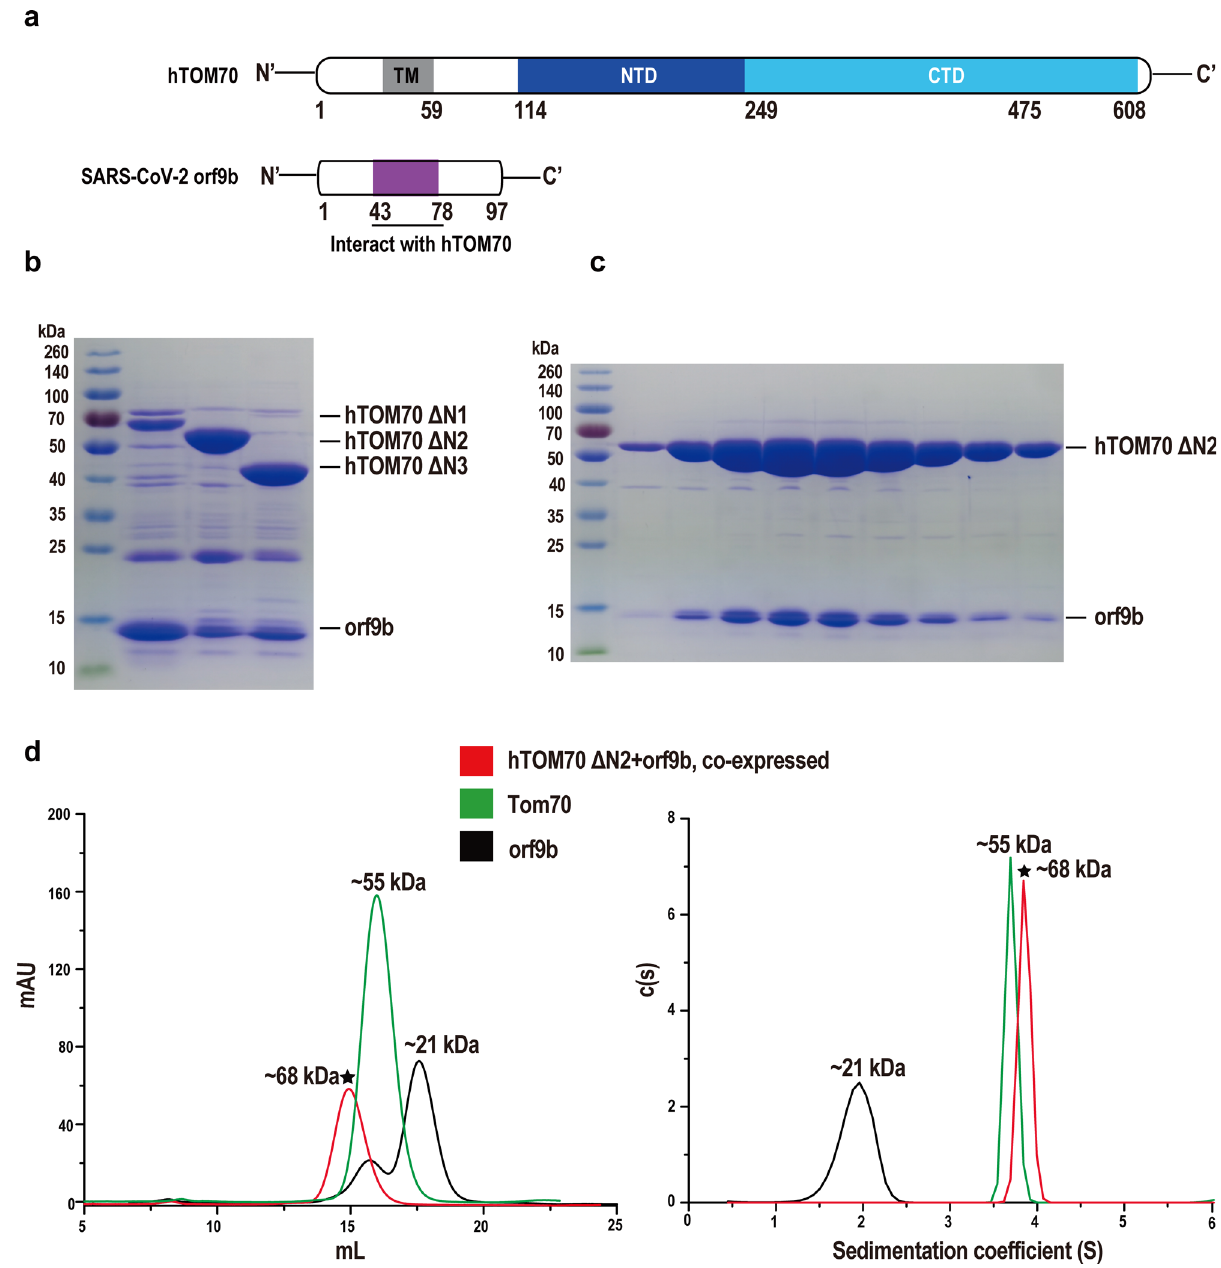
transmembrane domain, NTD N-terminal domain, CTD C-terminal domain. b When co-expressed in E coli , three of hTOM70 truncations, hTOM70 Δ N1 (60-608), hTOM70 Δ N2 (106-608), and hTOM70 Δ N3 (235-608) without fusion tag co-elute with SARS-CoV-2 orf9b with an N-terminal His-tag. c SDS-PAGE analysis of fractions eluted from gel fi ltration column, demonstrating hTOM70 Δ N2 and SARS-CoV-2 orf9b formed stable complex. d Left, size-exclusion chromatography and right, analytical ultracentrifugation analyses three samples: co-expressed SARS-CoV-2 orf9b/hTOM70 Δ N2 complex (red), alone expressed hTOM70 (green) and SARS-CoV-2 orf9b (homodimeric, black). The calculated molecular weight is indicated on top of the peaks. Data for SARS-CoV-2 orf9b/hTOM70 Δ N2 complex are indicated with